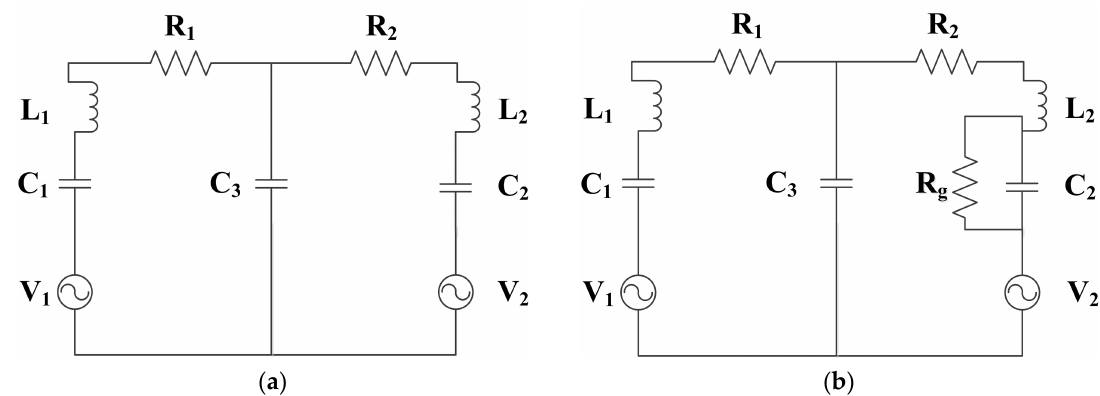
Figure 6. Effective circuit model of PIT without ( a ) and with ( b ) the graphene layer.